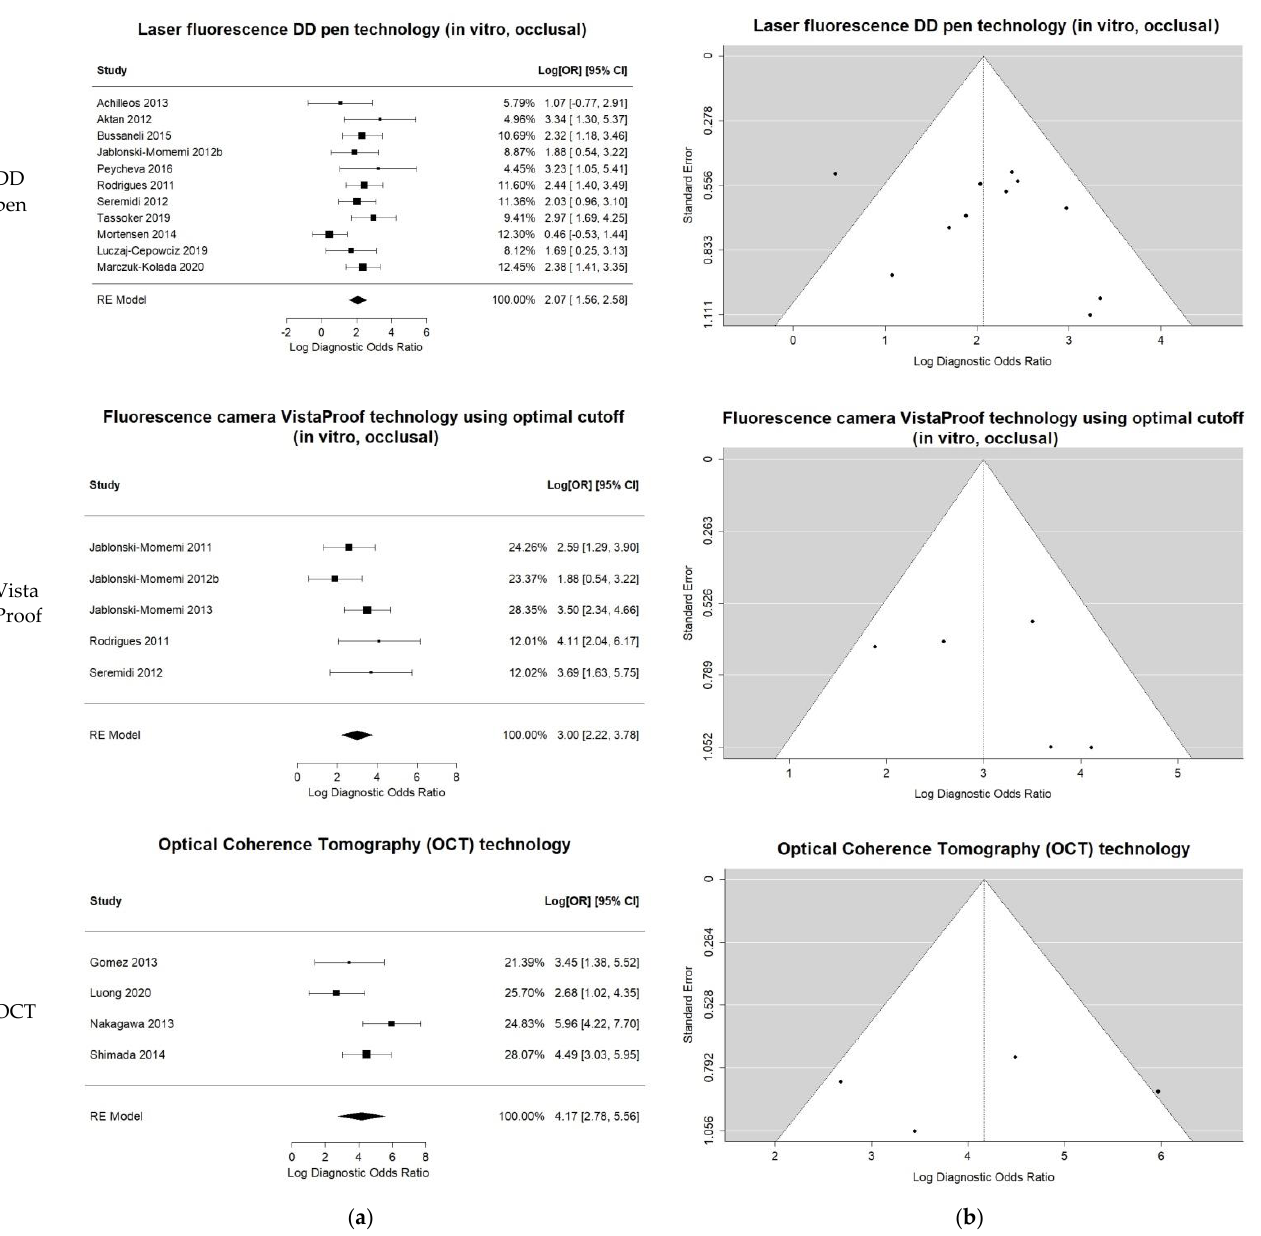
Figure 3. Univariate summary plots for the three groups of index tests included in the comprehensive bivariate meta-analysis: LF DD pen occlusal, in vitro; FC VistaProof using optimal cut-off, in vitro; OCT overall. ( a ) Log DOR forest plots and random effects aggregate estimates. ( b ) Log DOR funnel plots to illustrate the publication bias as patterns of individual studies clustering around the mean